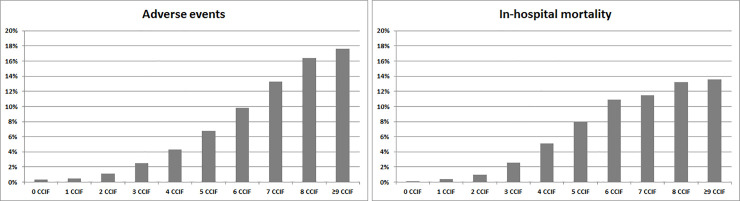
Proportions of AE and in-hospital mortality according to the number of care complexity individual factors.